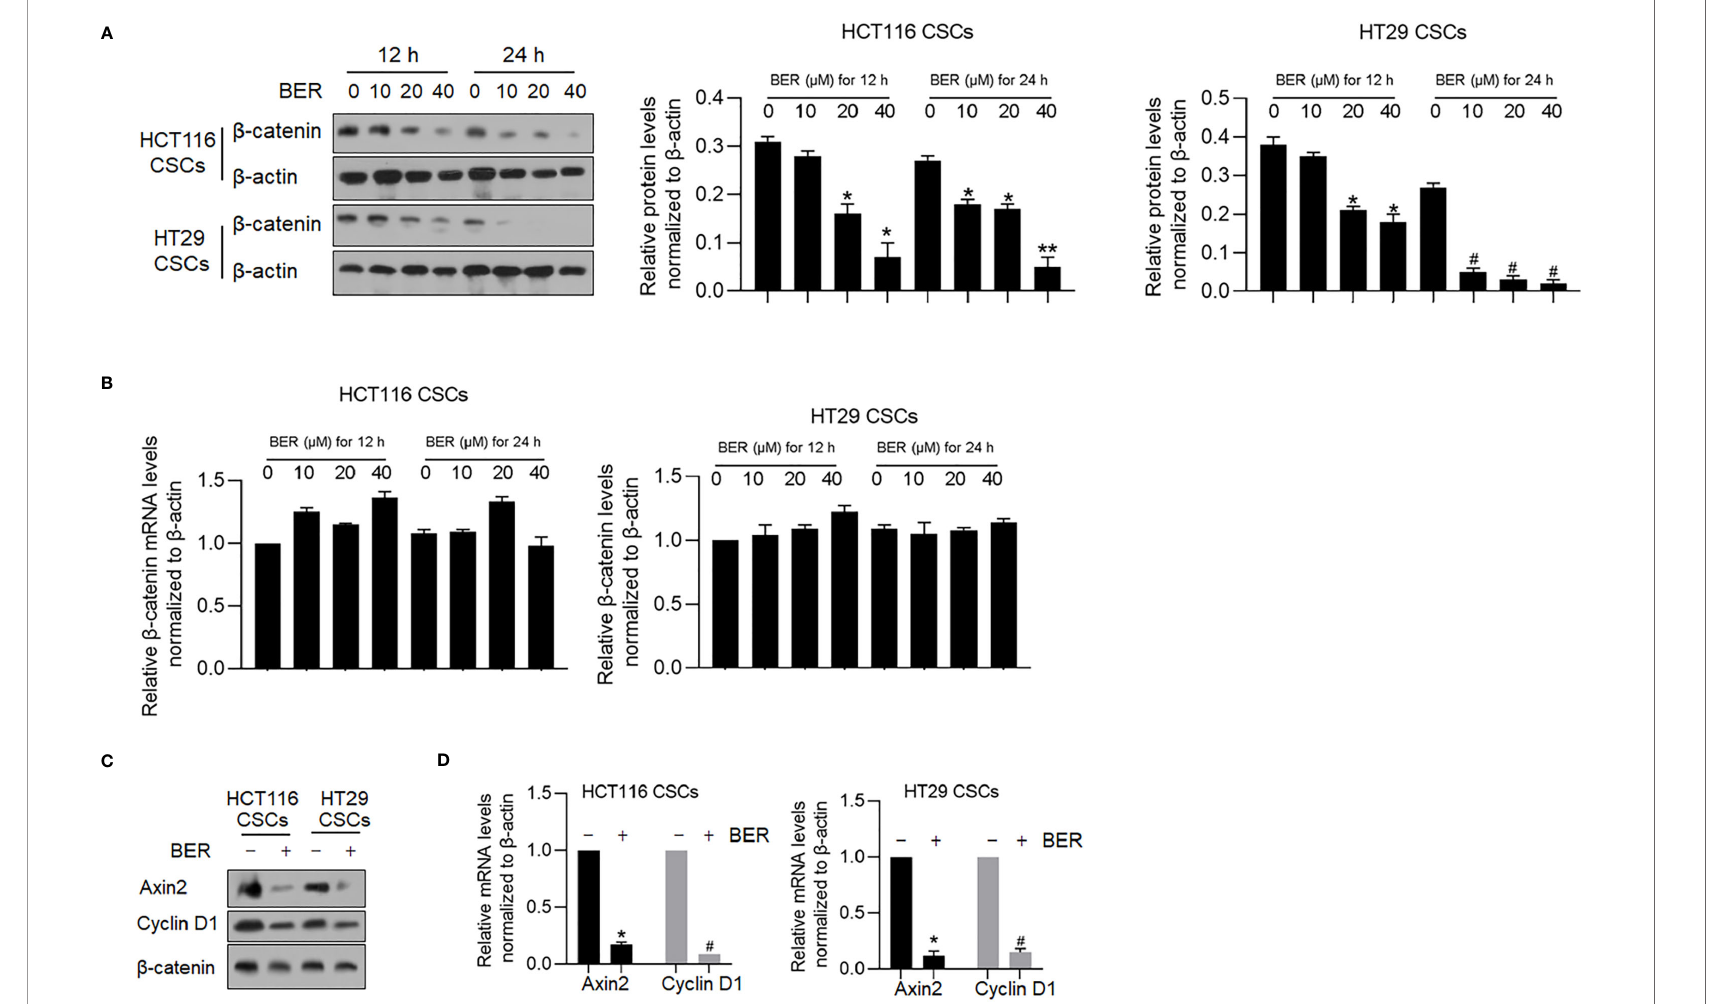
FIGURE 9 | Berberine decreased b -catenin and its downstream target genes. (A) After 12 or 24 h treatment using 10, 20, and 40 m M of Berberine, b -catenin protein levels were measured by Western blot in both HCT116 and HT29 CSCs. *p < 0.05, vs. mock group at 12 h; # p < 0.05, vs. mock group at 24 h. (B) After 12 or 24 h treatment using 10, 20, and 40 m M of Berberine, b -catenin mRNA levels were measured by RT-qPCR. After 40 m M of Berberine treatment, Axin2 and Cyclin D1 protein levels were measured by Western blot and RT-qPCR (C&D). *p < 0.05, vs. mock group; # p < 0.05, vs. mock group.**P < 0.01, vs. mock group at 24